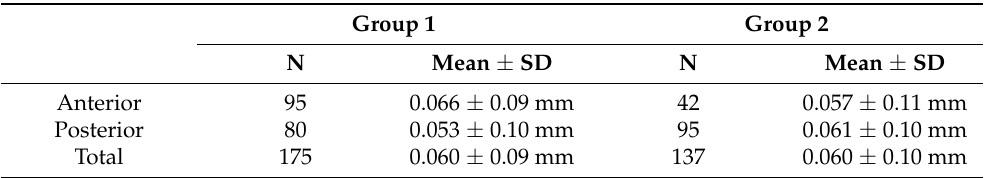
Table 3. MBL change for different groups (Group 1: EA > 30 ◦ ; Group 2: EA ≤ 30 ◦ ) by implant site (anterior and posterior). N: number of implants; SD: Standard Deviation.